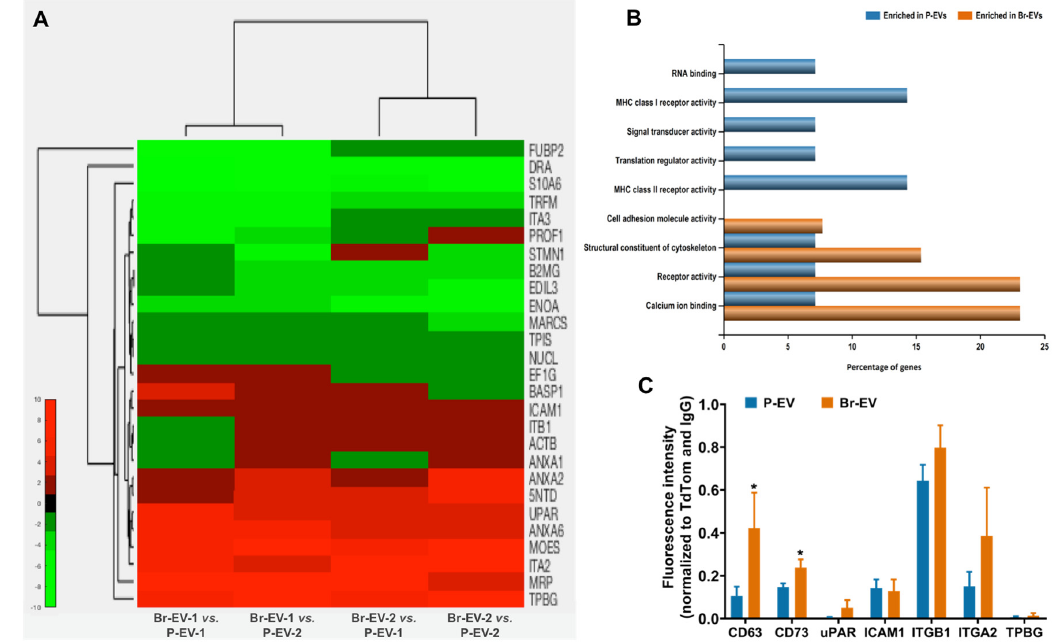
Figure 2. Br-EVs are enriched in interacting partners of the clathrin-independent carrier / GPI-AP-enriched compartments (CLIC / GEEC) cargo. ( A ) Heatmap visualization of quantitative proteomics analyses demonstrating the significantly differentially expressed proteins ( p ≤ 0.05) in Br-EVs vs. P-EVs (red demonstrates upregulation in Br-EVs). ( B ) Functional enrichment analysis of proteins upregulated in P-EVs (blue) and Br-EVs (orange). ( C ) Quantification of surface localization of membrane-associated proteins upregulated in Br-EVs, CD63 serves as positive control (mean ± SD; three independent experiments). Statistical analysis was performed using unpaired two-tailed Student’s t -test (* p ≤